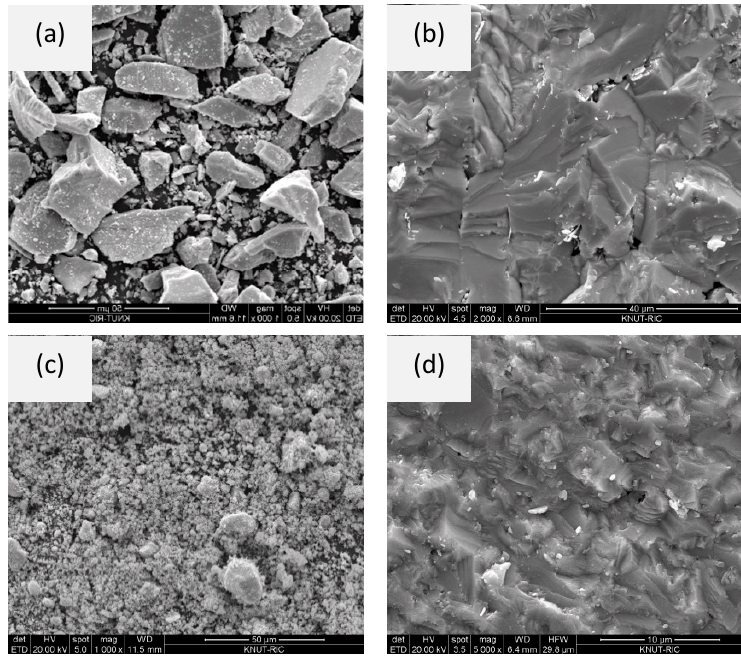
Figure 2. SEM images of controlled melting sample pulverized by ( a ) mortar-pestle and ( c ) HEVM and subsequently VHPed ( b ), ( d ).